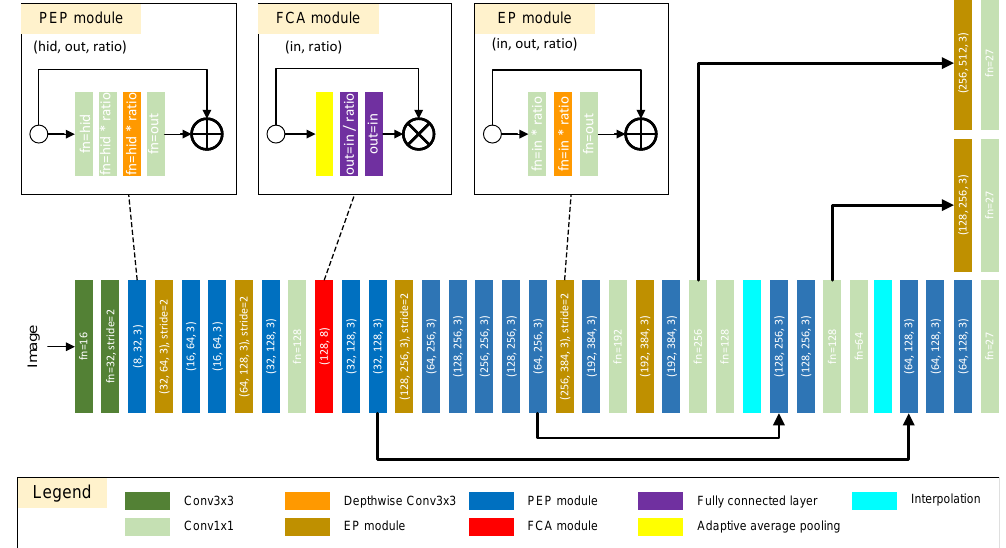
Figure 2. Theschematic diagram of the YOLO Nano Underwater architecture. EP stands for the Expansion Projection macro architecture, and PEP stands for the residual Projection Expansion Projection structure. FCA is a lightweight Fully Connected Attention module. The specific parameters of each layer are shown in the blocks. Batch normalizations and activations are omitted for simplicity. * stands for multiply. Better viewed in zoom and